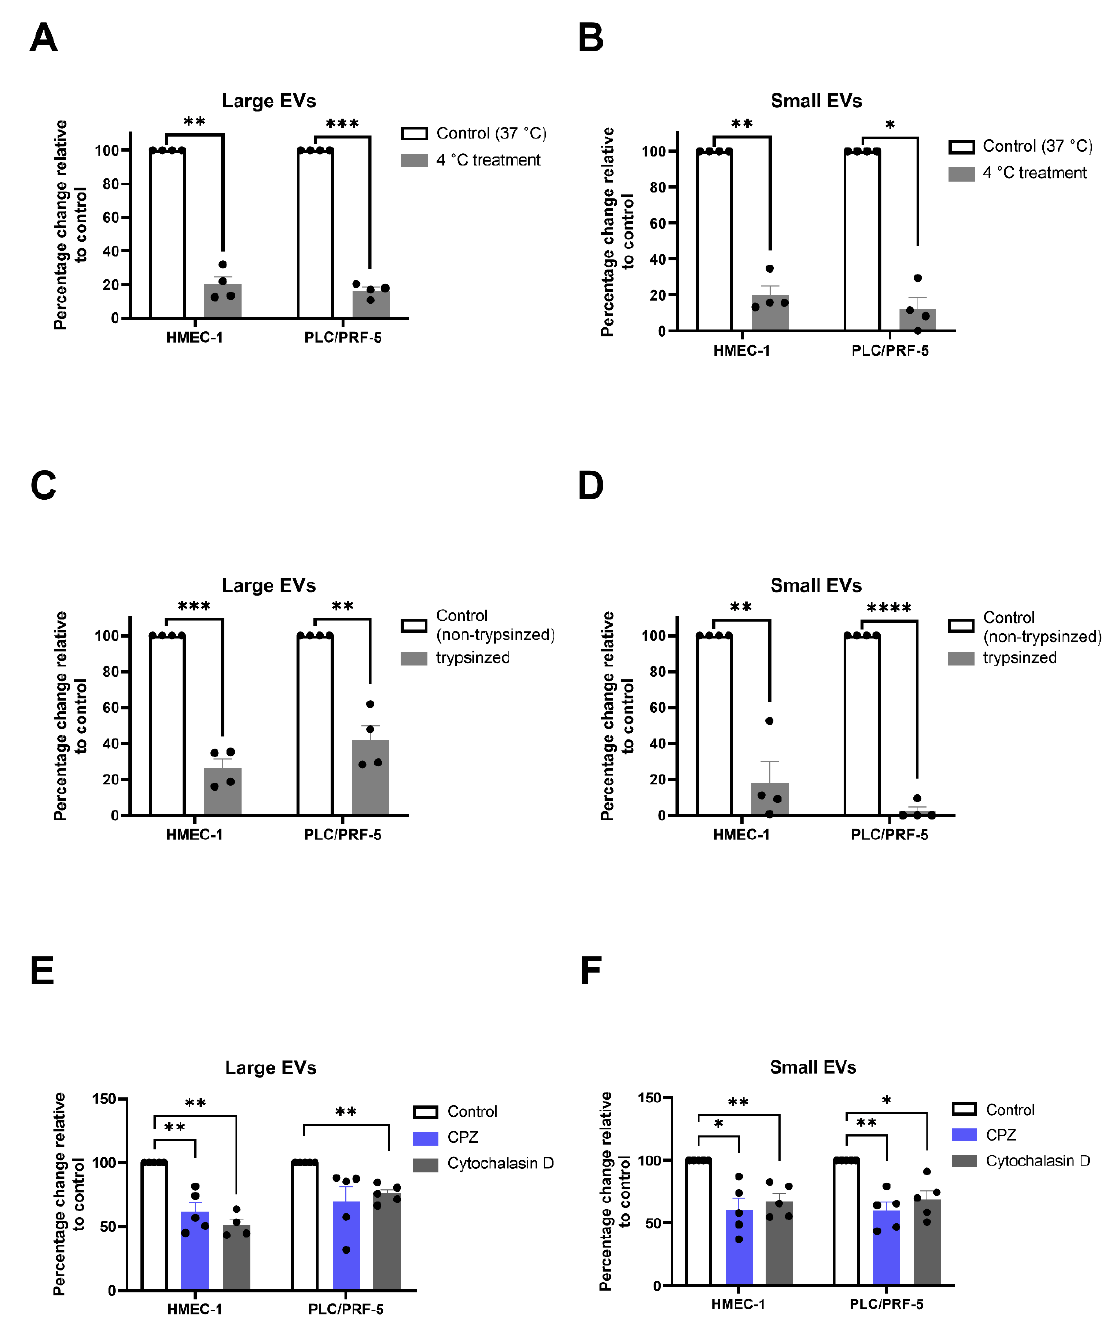
Figure 3. Inhibition of the interaction of the placental EVs with the recipient cells. HMEC-1 and PLC/PRF-5 were pre-cultured at 4 ◦ C for 0.5 h. Fluorescently labelled placental ( A ) large or ( B ) small EVs were added, and the cultures continued for 2 h at 4 ◦ C ( n = 4). HMEC-1 and PLC/PRF-5 were treated with placental ( C ) large or ( D ) small EVs that had been treated with 0.25% ( w / v ) trypsin, for 2 h ( n = 4). HMEC-1 and PLC/PRF-5 were pre-treated with cytochalasin D (10 µ g/mL) or chlorpromazine hydrochloride (CPZ, 10 µ g/mL) for 30 min, and the fluorescently labelled placental ( E ) large or ( F ) small EVs were added to the cultures in the presence or absence of the inhibitors for 2 h ( n = 4–5). The interaction of the EVs was quantified using a BioTek Synergy 2 microplate reader (Agilent, CA, USA). Values were normalized to control EV group and shown as mean ± SEM. Differences between the two groups were tested with a paired t -test (* p < 0.05, ** p < 0.01, *** p < 0.001, **** p <